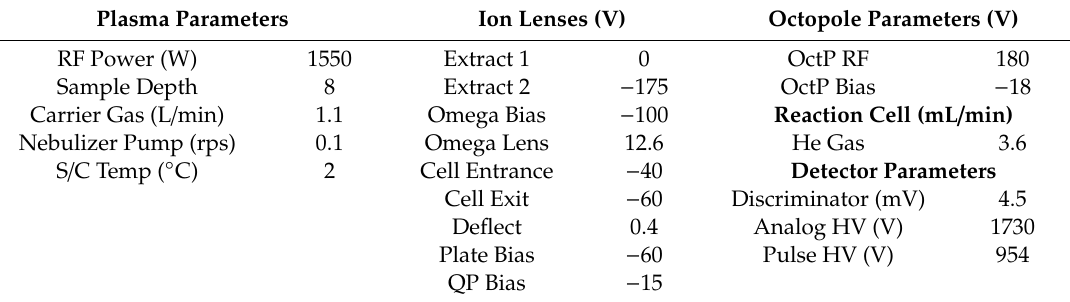
Table 1. ICP-MS parameters